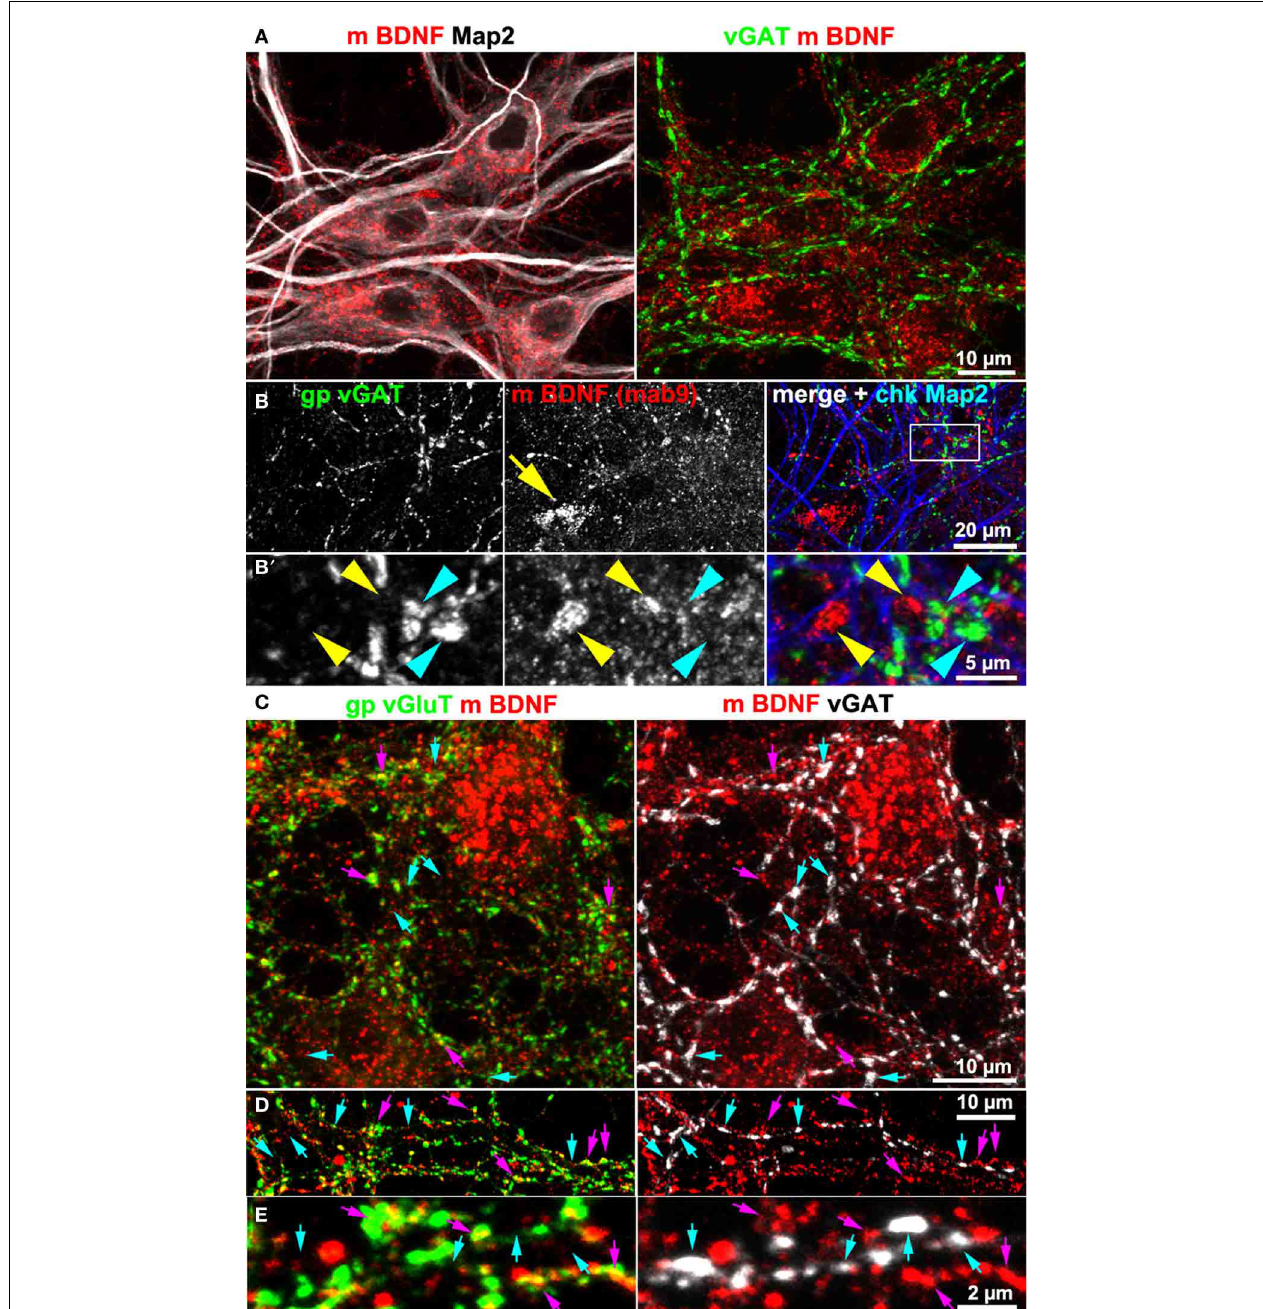
FIGURE 3 | BDNF immunoreactivity is low at GABAergic synapses. (A,B) vGAT and Map2 staining of hippocampal neurons (DIV 25–DIV 31). vGAT + structures did not show BDNF enrichment. Somatic BDNF staining ( yellow arrow in B) was not associated with vGAT+ neurons. (B’) ( detail in B) . Dense anti-BDNF staining (yellow arrowheads) was almost absent from vGAT +